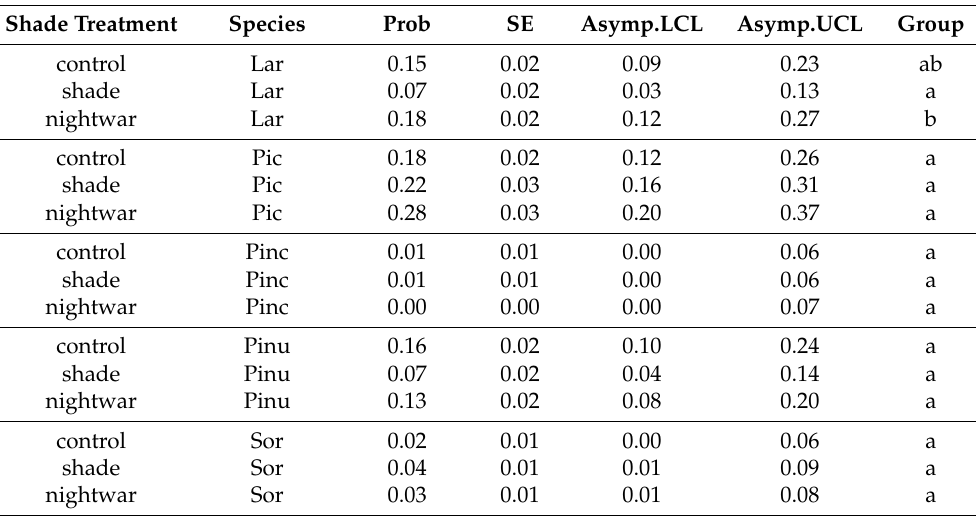
Table A2. Model estimates (prob = probability of mortality) and Tukey-adjusted comparisons (sky exposure:species), averaged over snow treatments, in the GLM assessing the effect of snow and sky-exposure treatments on final mortality of seedlings planted in autumn 2013, assessed in 2014. Species: Lar = Larix decidua , Pic = Picea abies , Pinc = Pinus cembra , Pinu = Pinus uncinata, Sor = Sorbus aucuparia . SE = Standard error, Asymp.LCL and Asymp.UCL = asymptotic lower and upper control limits. Groups indicate significant differences between sky-exposure treatments within species . MORTALITY 2013/14 Pair-Wise Comparisons, Sky Exposure: